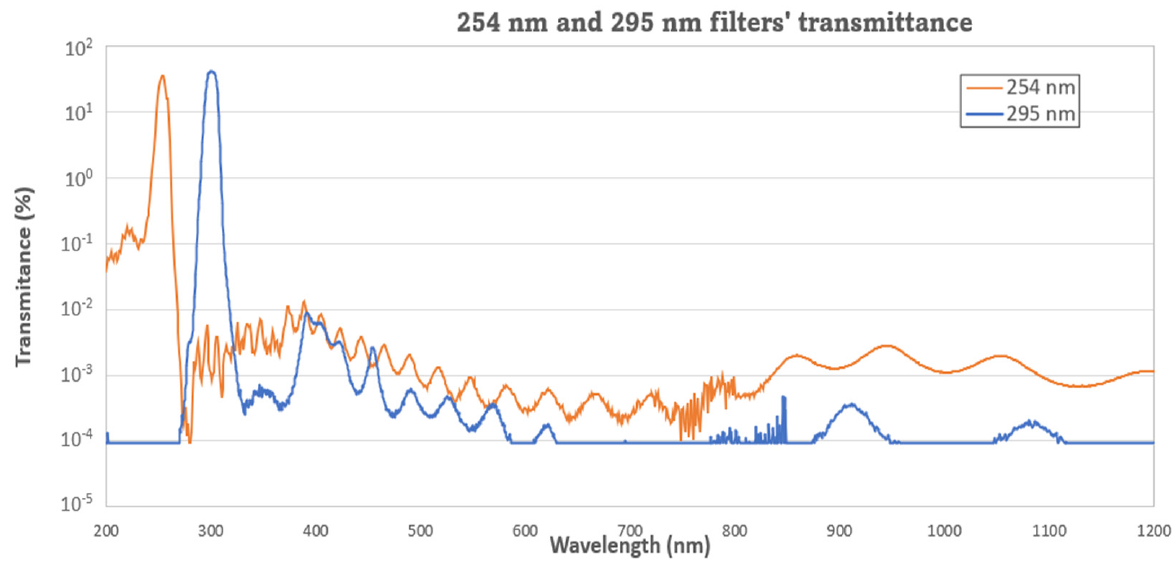
Figure 5. UV interferential filters final performance.